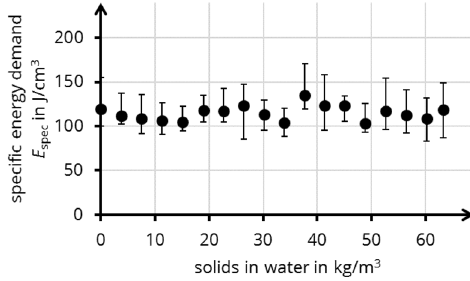
Fig. 19 Specific energy demand depending on the solid particles in water